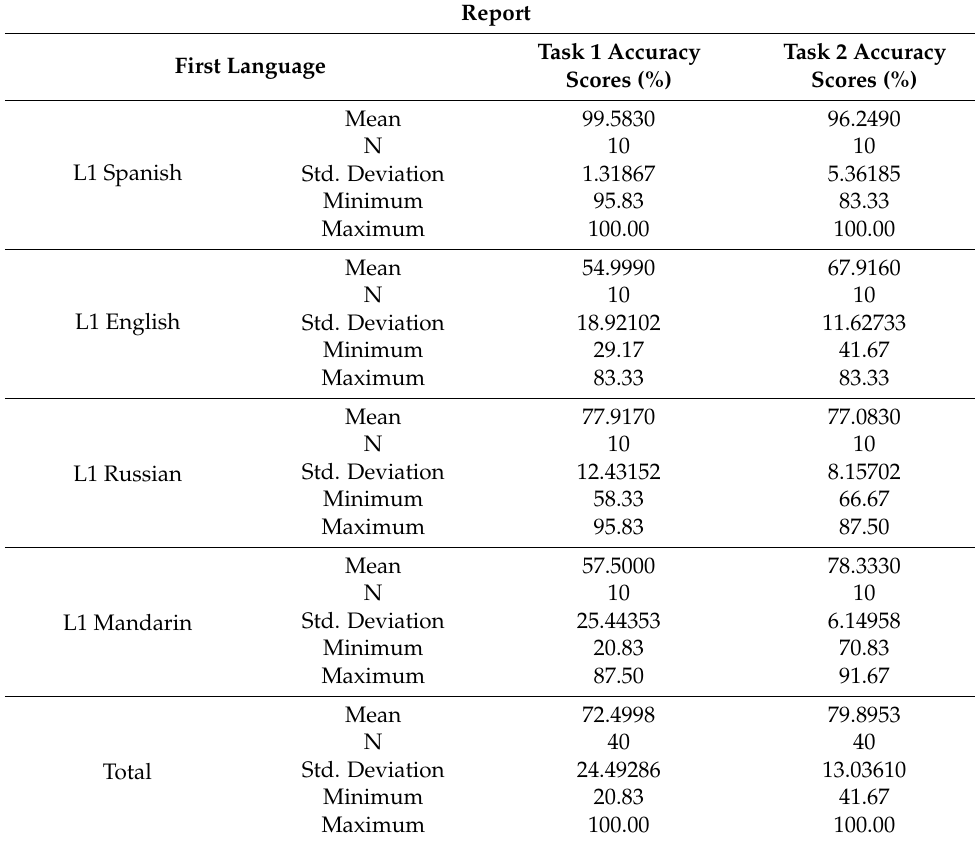
Table 5. Accuracy scores (%) among beginner groups on two